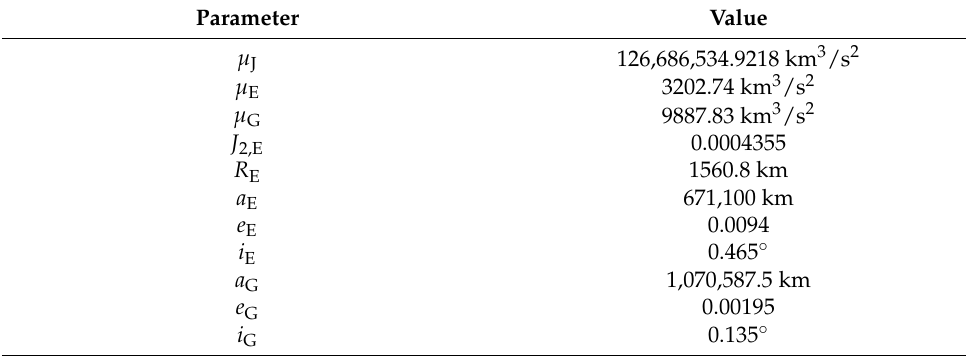
Table 1. Dynamical parameters of the Jovian system